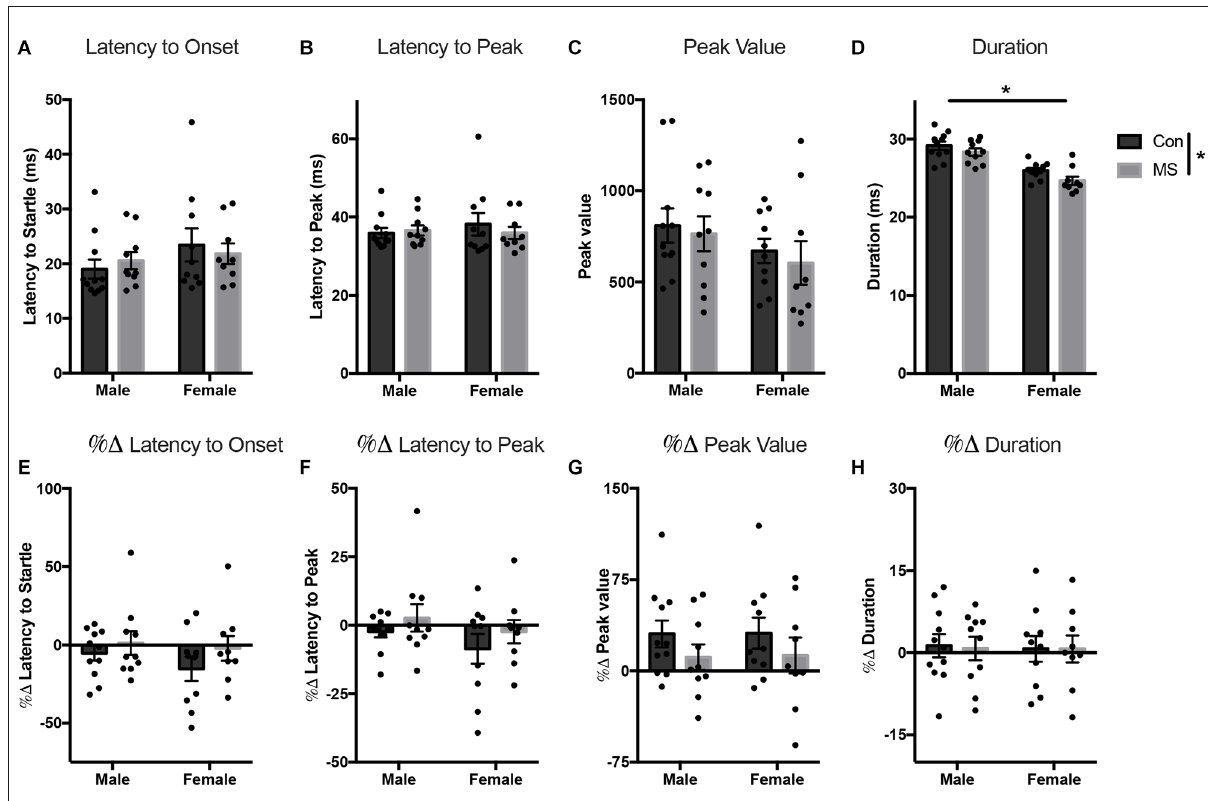
FIGURE4 Results from Experiment 2. Effects of MS on baseline and light-enhanced startle on P54–55. Graphs depict the latency to onset (ms) (A) , latency to peak (ms) (B) , peak value (arbitrary units) (C) , and duration (ms) (D) at baseline and the percent change from baseline in latency to onset (E) , latency to peak (F) , peak value (G) , and duration (H) during exposure to light. Control-reared groups are depicted by dark gray bars and MS-reared groups are depicted by light gray bars. Figures represent the mean group values ± SEM. Individual subjects are depicted by data points. * p <